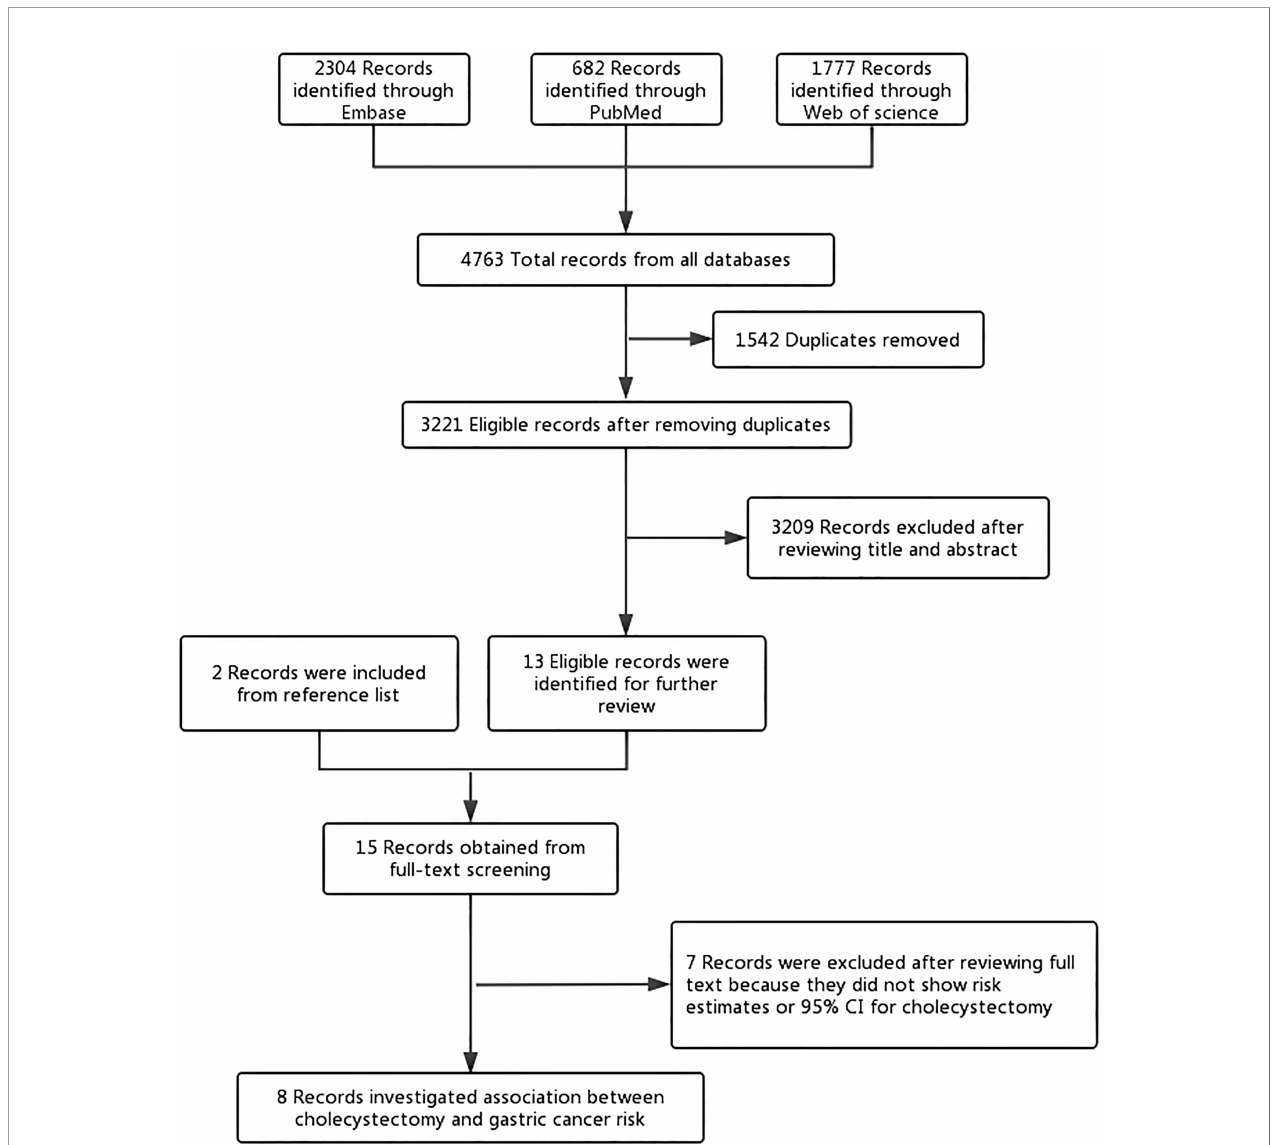
FIGURE 1 | Flowchart of the study selection. The fl owchart shows the process used to select studies for our meta-analyses focusing on the association between cholecystectomy and gastric cancer